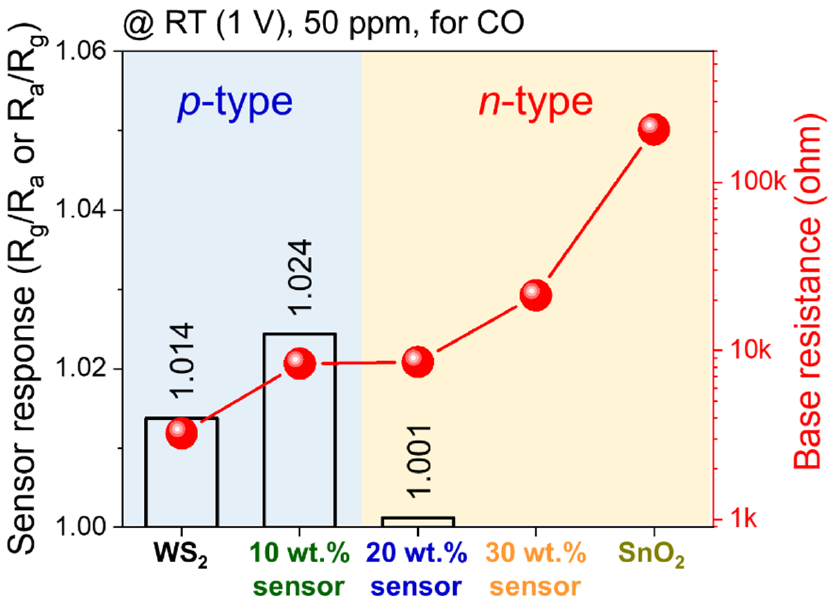
Figure 3. Comparison between the responses and base resistance of different gas sensors to 50 ppm CO at 20 °C under 1 V applied voltage.